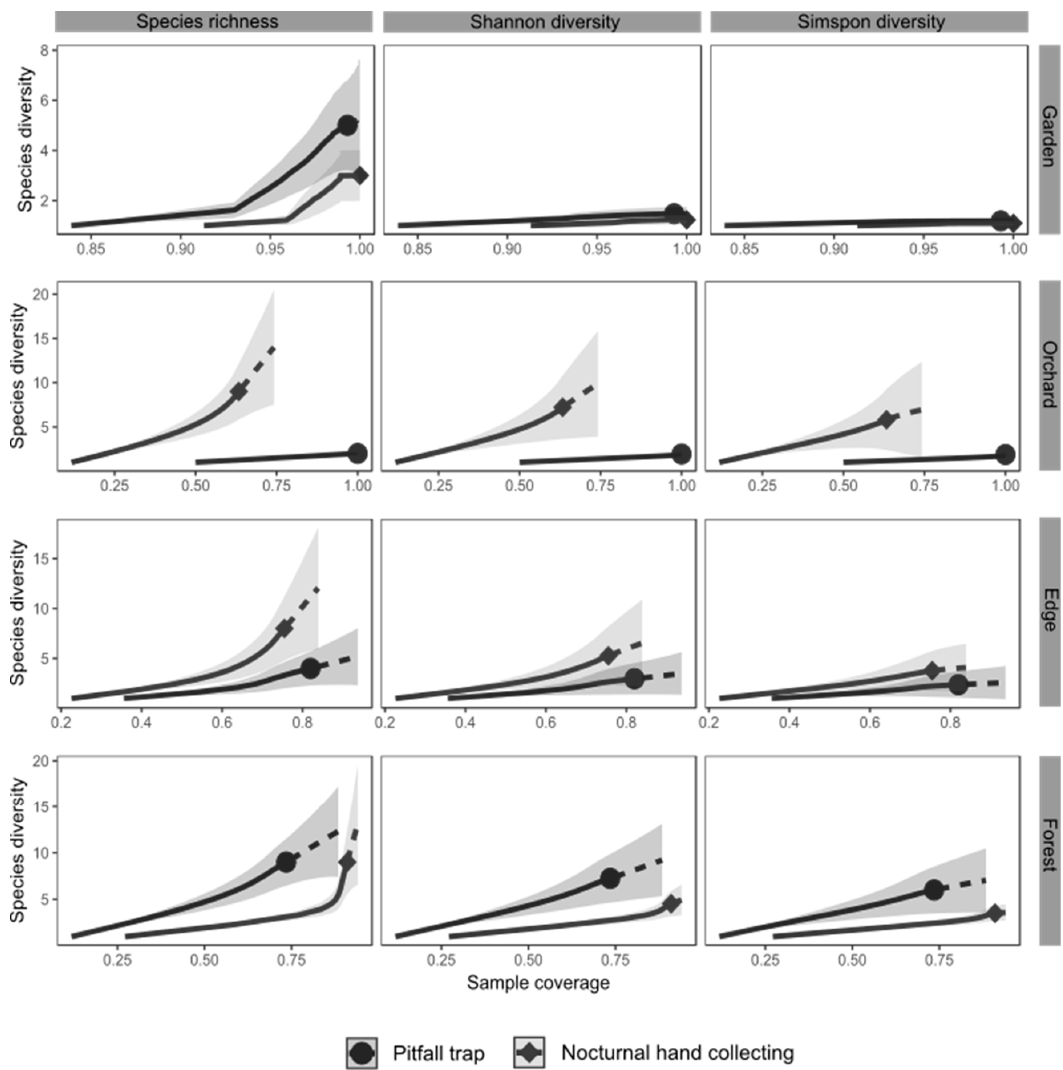
Figure 1. Estimated taxonomic diversity (species richness, Shannon, and Simpson diversities) in all four habitats for each sampling method. 95% confidence intervals are represented in a light color and were obtained by 200 bootstrap replications. Plain lines represent interpolated diversity, whereas dotted lines